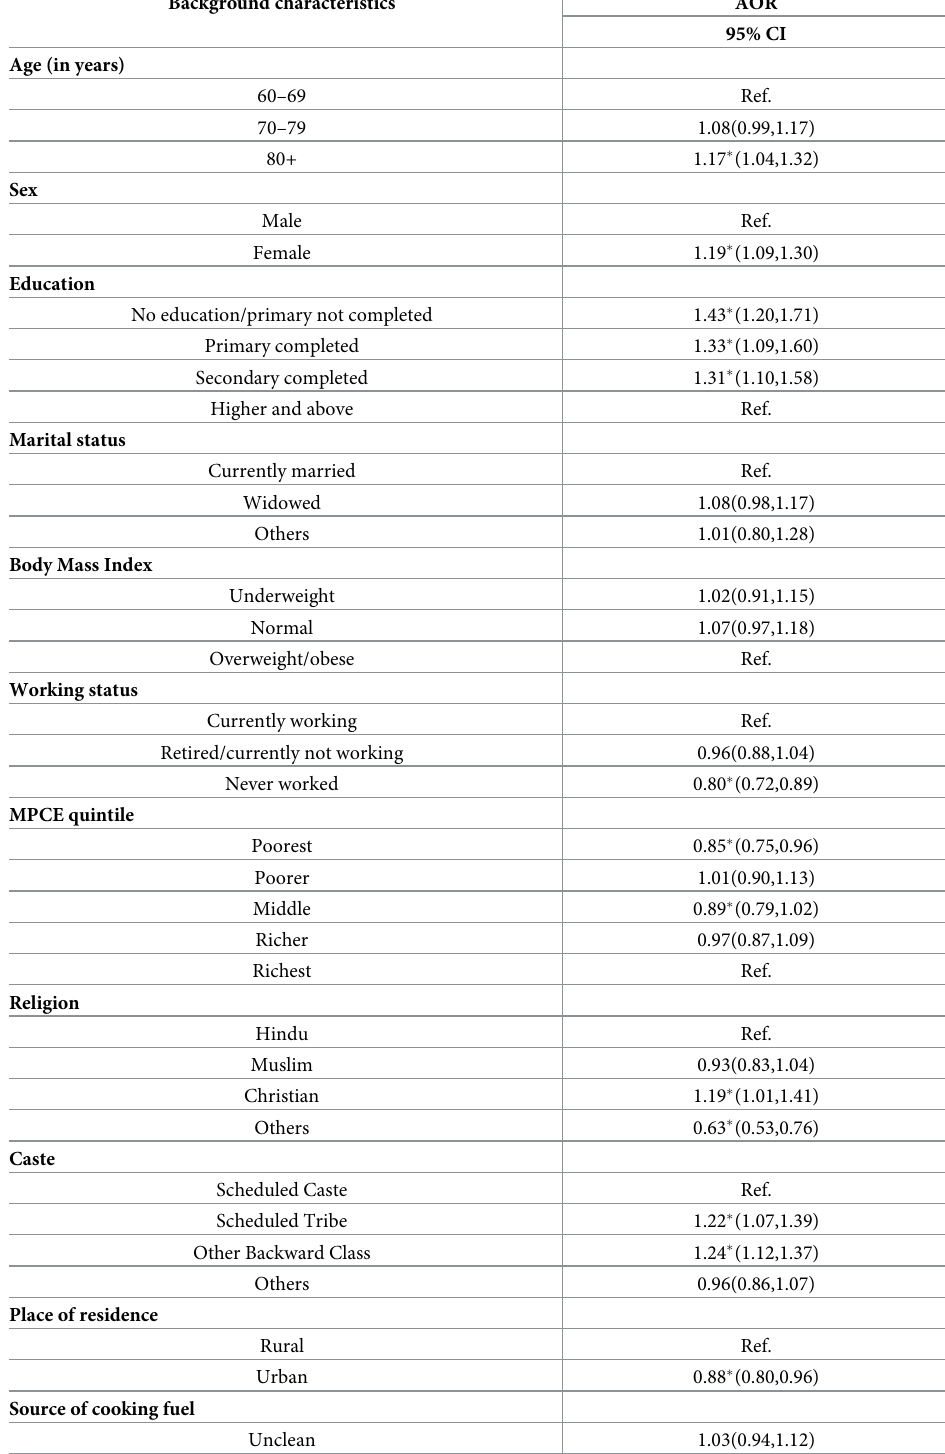
Table 4. Logistic regression estimates for older adults who suffered from diarrhoea by their background charac- teristics in India,